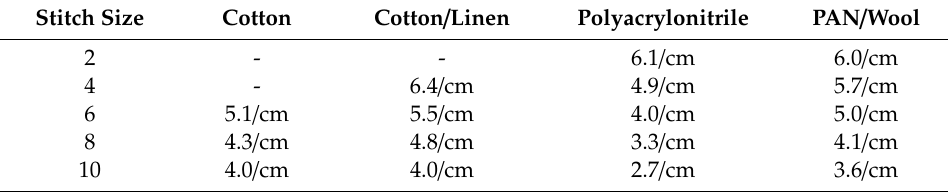
Table 5. Course density of knitted fabrics under examination in this study.